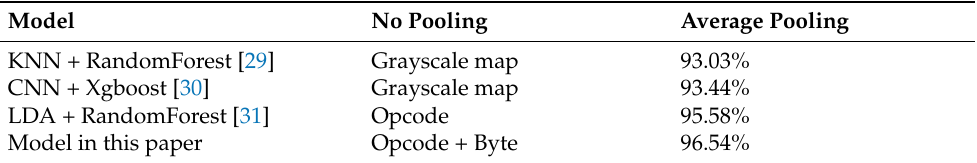
Table 9. 2-Class-Datacon model